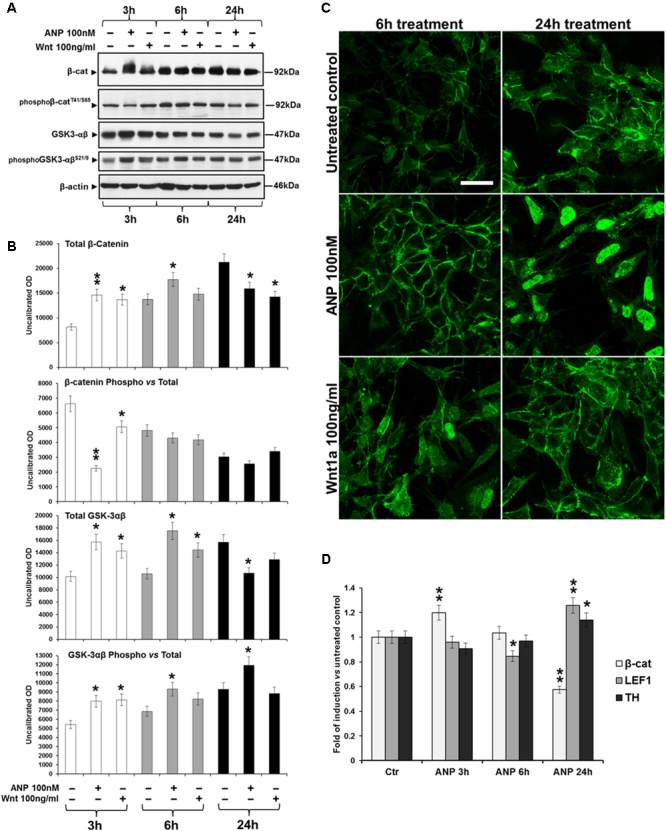
Atrial natriuretic peptide (ANP) modifies β-catenin intracellular distribution and inhibits β-catenin degradation in SHSY5Ywt cells. (A) WB analyses of total and phosphorylated β-catenin (pβ-cateninT41/S65), and of total and phosphorylated GSK-3β (pGSK-3βSer9) levels in total cell lysates from ANP treated SHSY5Ywt cells, compared to that from untreated control and Wnt1a treated samples; analyses were performed after 3, 6, and 24 h of treatment. (B) Results from the densitometric analysis of total and phosphorylated β-catenin and GSK-3β, performed using the ImageJ processing program [http://rsbweb.nih.gov/ij/]; values were normalized to β-actin, for total β-catenin and GSK-3β, or vs the total levels of each protein for the phosphorylated forms. Results are the mean from three independent experiments. Significance vs untreated relative control: ∗p < 0.05; ∗∗p < 0.01; the mean ± SD; n = 3. (C) Confocal microscopic images showing the intracellular distribution of β-catenin in control and ANP or Wnt1a treated cells after 6 and 24 h of culture. Bar: 25 μm. (D) Effect of ANP on the transcription of β-catenin (β-cat), LEF1 and TH genes in SHSY5Ywt cells. Cells were treated with 100 nM ANP and processed for RT-qPCR analysis after 3, 6, and 24 h of treatment. Significance vs control (Ctr): ∗p < 0.05; ∗∗p < 0.01; the mean ± SD; n = 3.